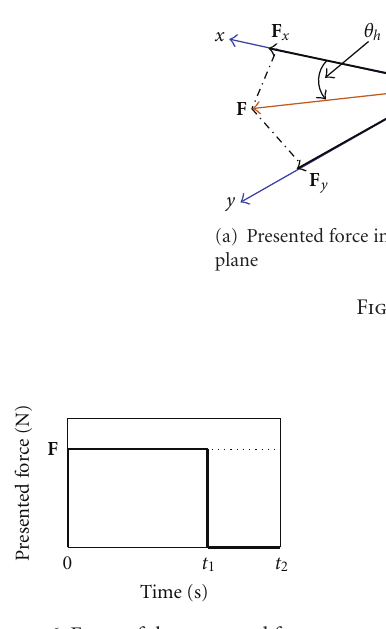
Figure 6: Form of the presented